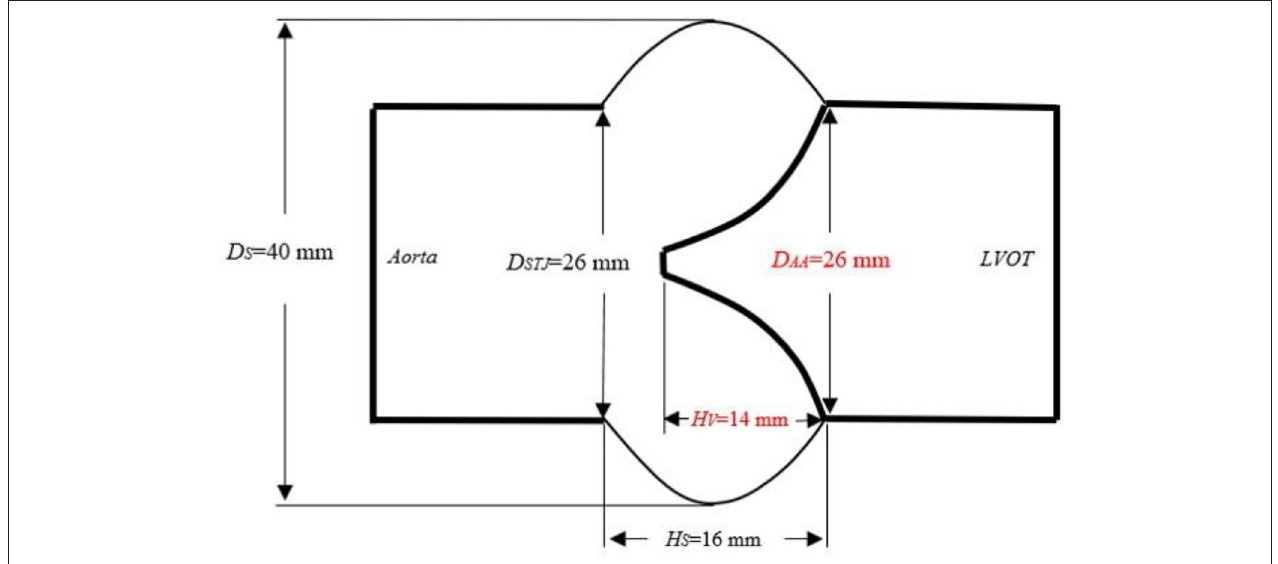
FIGURE 1 | Schematic diagram of the aortic root size. D AA , aortic annulus diameter; H V , valve height; L H , valve length; D STJ , diameter of the sinotubular junction; H s , sinus height; D S , sinus diameter; LVOT, left ventricular outflow